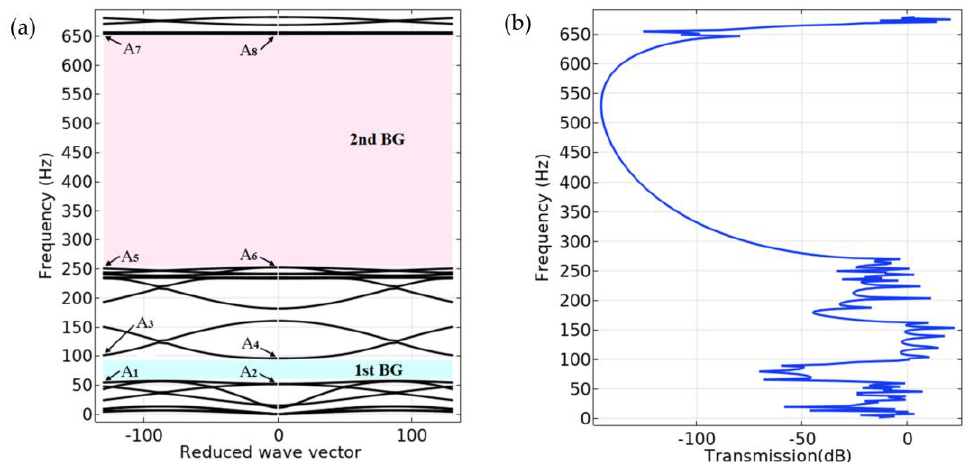
Figure 2. ( a ) Band structure of the proposed S-type oscillator. ( b ) Transmission power spectrum of S-type oscillator with three periods.